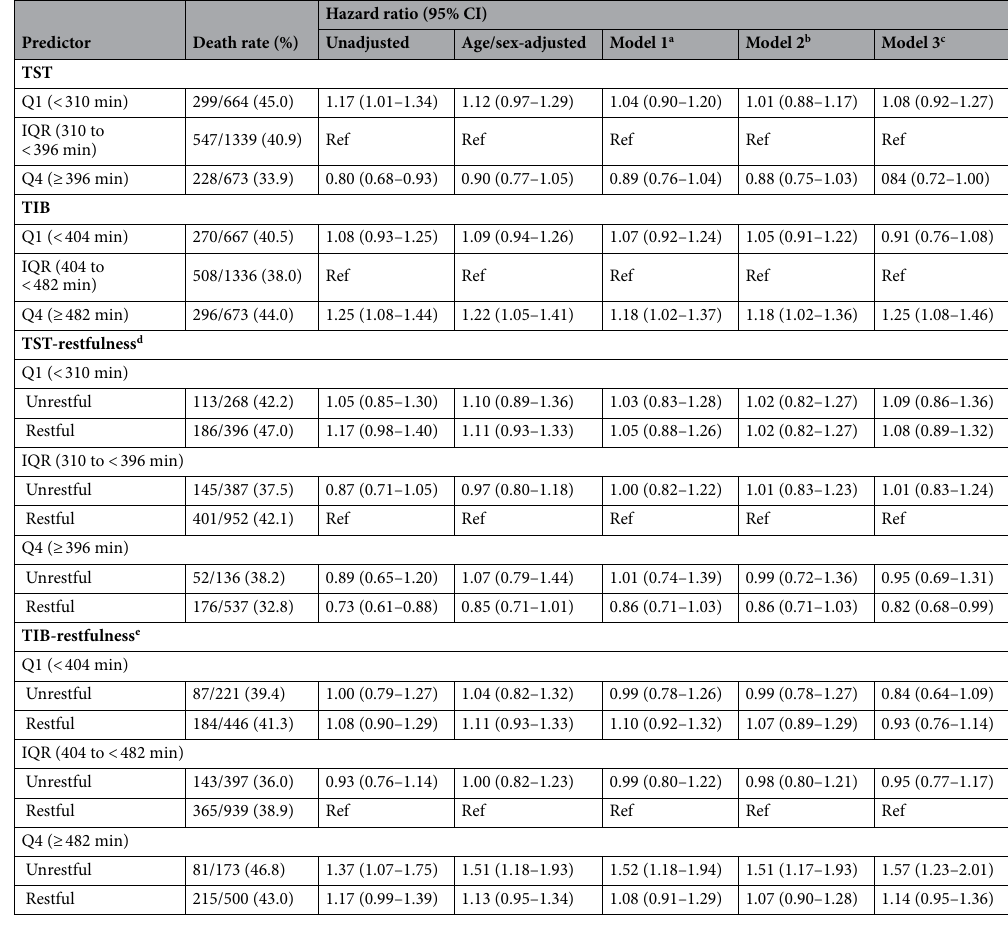
Table 4. Mortality hazard ratios from cox regression for older adults (n = 2676). CI confidence interval, IQR interquartile range, Q1 lowest quartile, Q4 highest quartile, Ref reference, TIB time in bed, TST total sleep time. a Model 1 included age, sex, race (Caucasian vs. other), body mass index, smoking status, apnea hypopnea index with 4% desaturation, sleep time with saturated oxygen below 80%, stroke, myocardial infarction, hypertension, diabetes, and physical functioning standardized score on the Short Form 36 Health Survey. b Model 2 included Model 1 plus antidepressants, benzodiazepines, Epworth Sleepiness Scale score, number of daytime naps per week, weekend-weekday difference in habitual sleep duration, insomnia or poor sleep, and percent time in rapid eye movement sleep. c Model 3 included Model 2 plus TIB in TST/TST-restfulness models or TST in TIB/TIB-restfulness models. d P = 0.22 for interaction between categorical TST and sleep restfulness variables. e P = 0.28 for interaction between categorical TIB and sleep restfulness